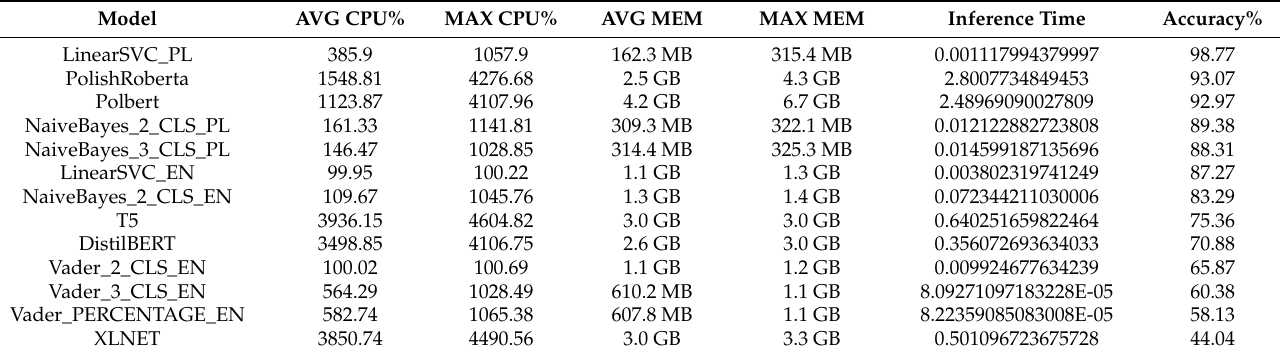
Table 4. Results of experiments for Polish-language models.